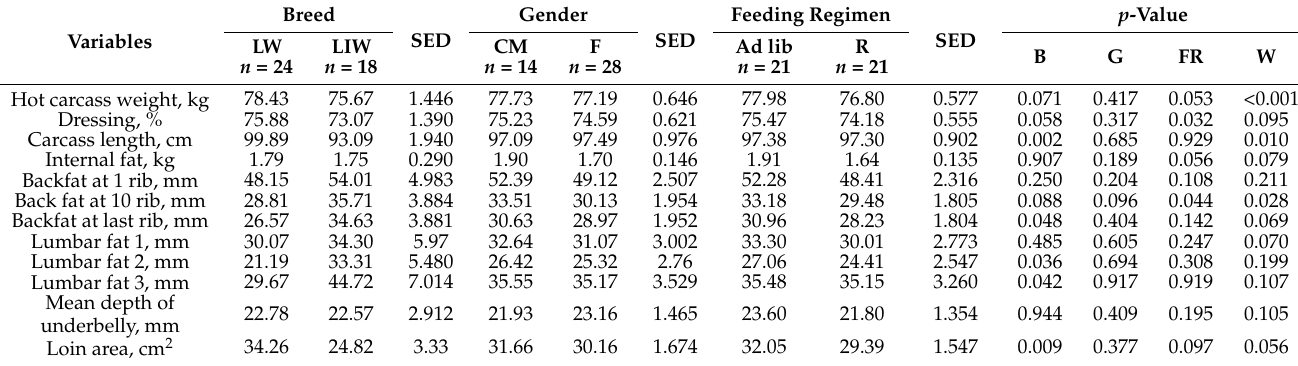
Table 3. Effects of breed, gender, and feeding intensity on pig carcass characteristics.